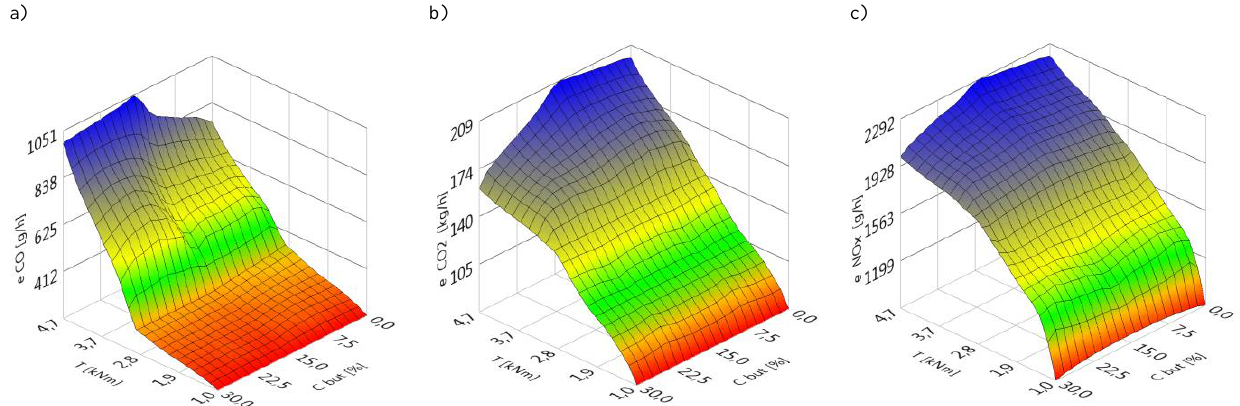
Fig. 7. The surface of emission intensity: a) carbon monoxide, b) carbon dioxide, c) nitrogen oxides at rotation speed n = 600